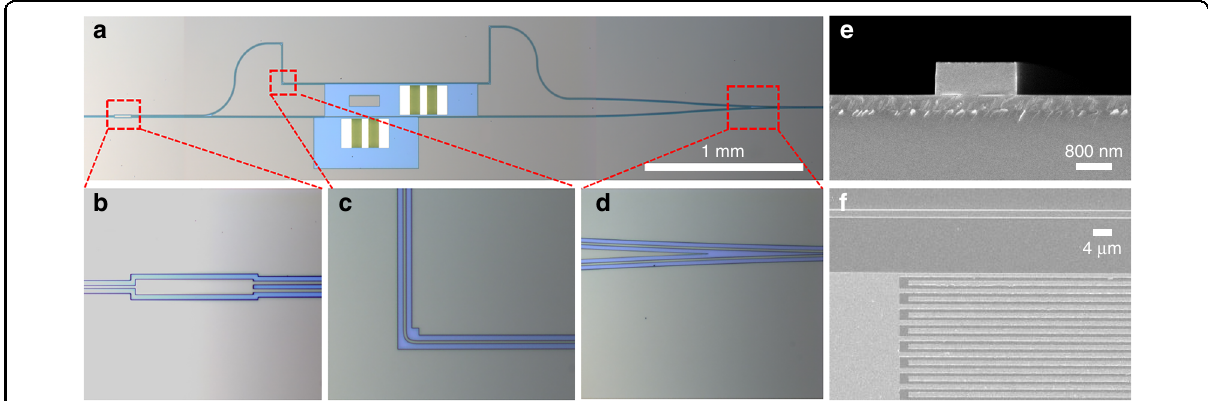
Fig. 2 Con fi guration of the built-in push-pull AO modulator over the nonsuspended TFLN-ChG hybrid waveguide platform. a Microscope image of a TFLN-ChG hybrid MZI-based AO modulator. The MZI is designed to allow careful switching between the single arm and double arm modulation mechanisms. b Zoomed-in microscope images of the 1 × 2 MMI coupler, ( c ) 90° bending waveguide, and ( d ) Y-combiner. e Cross- sectional SEM image of the modulated waveguide. f SEM image of the modulation area including the IDT and